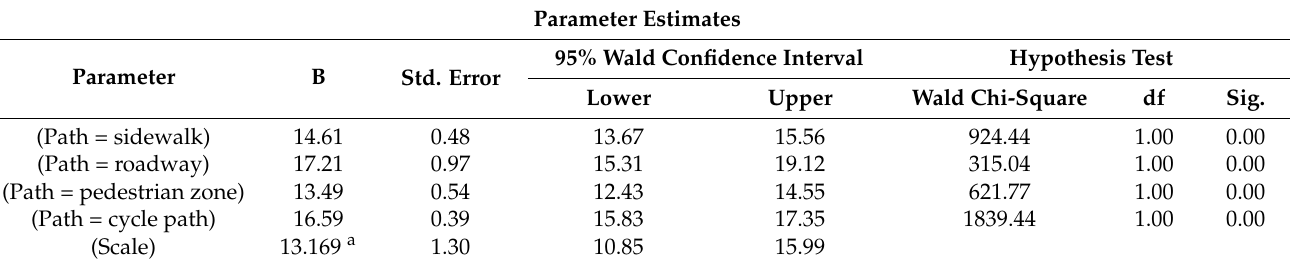
Table 7. Parameter Estimates for the Path